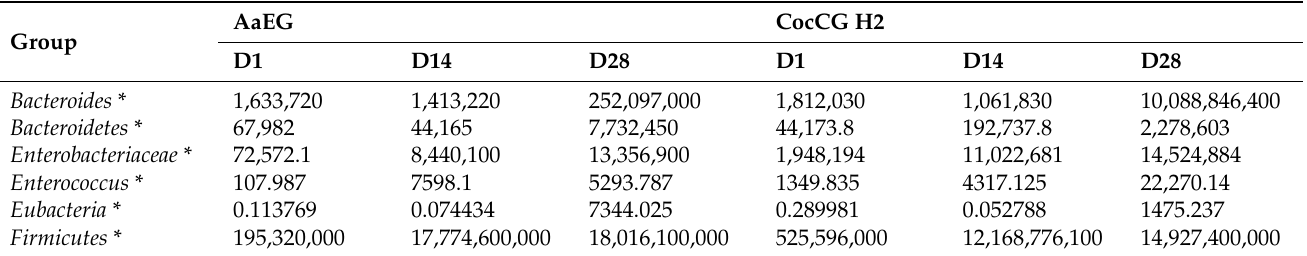
Table 5. Average number of genetic copies of intestinal bacterial population in the two experimental groups evaluated by qPCR.